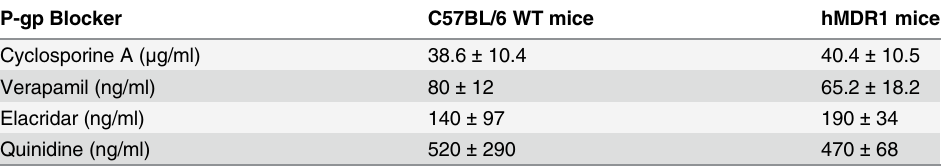
Table 4. Blood levels of the blockers used when studying digoxin transport in C57BL/6 WT and hMDR1